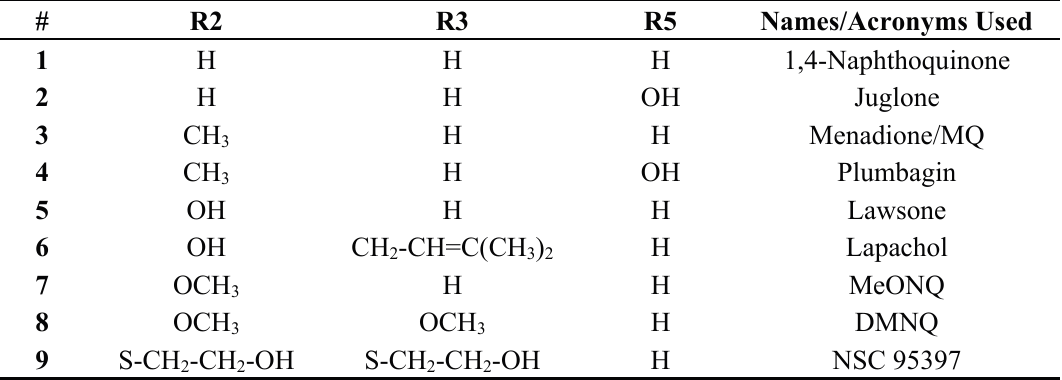
Table 1. List of naphthoquinones mentioned in this article (see Figure 1B for positions of R2, R3,